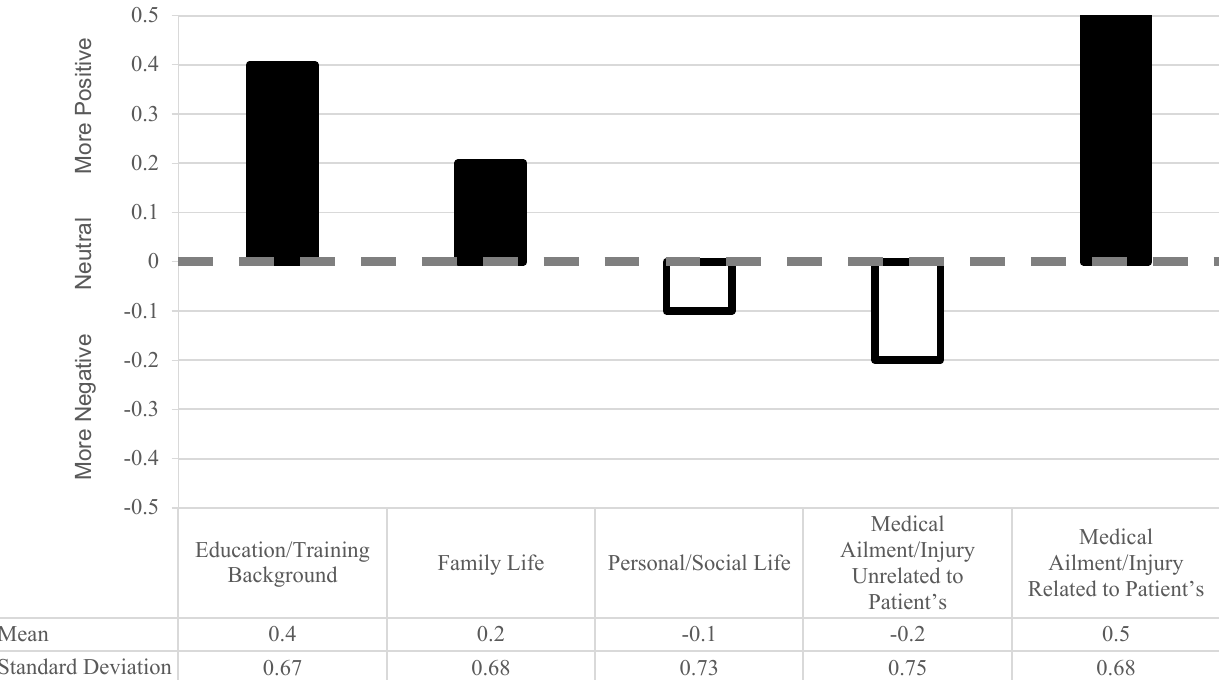
Figure . Patient Preferences Regarding Types of Self-Disclosure